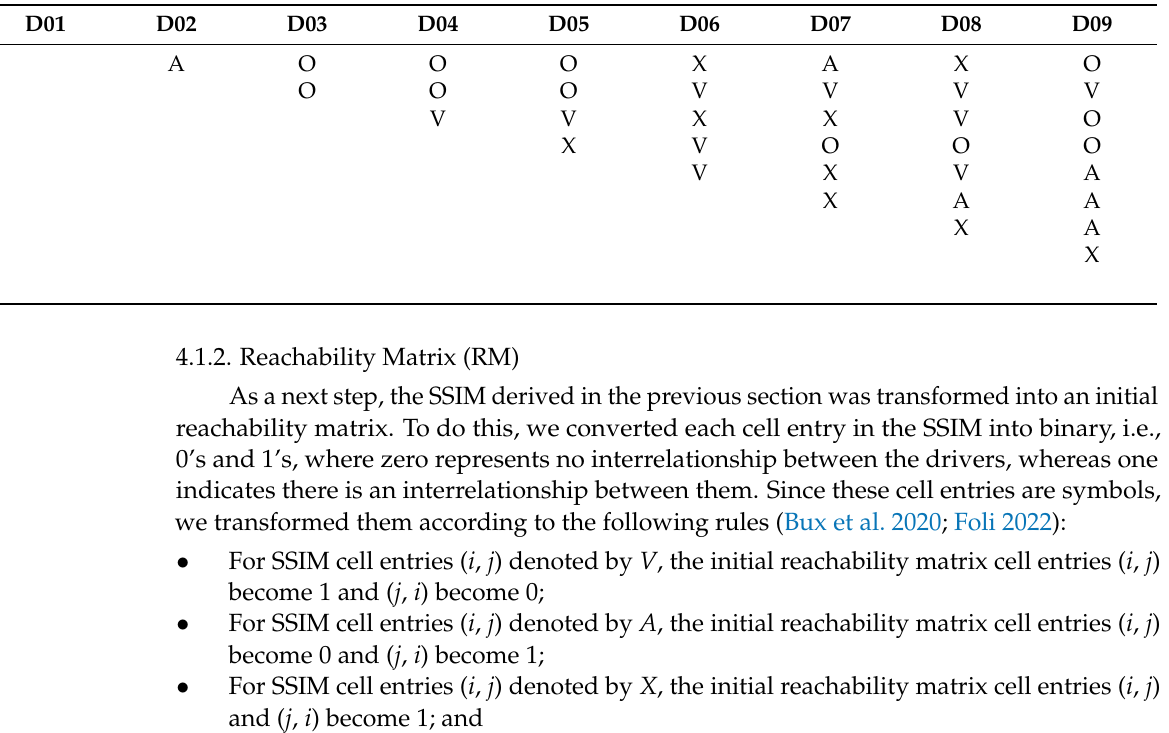
Table 2. Structural self-interaction matrix